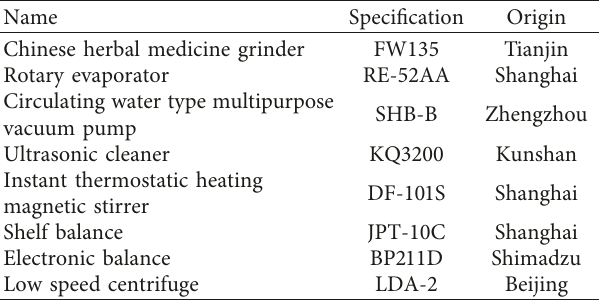
Table 1: Laboratory equipment